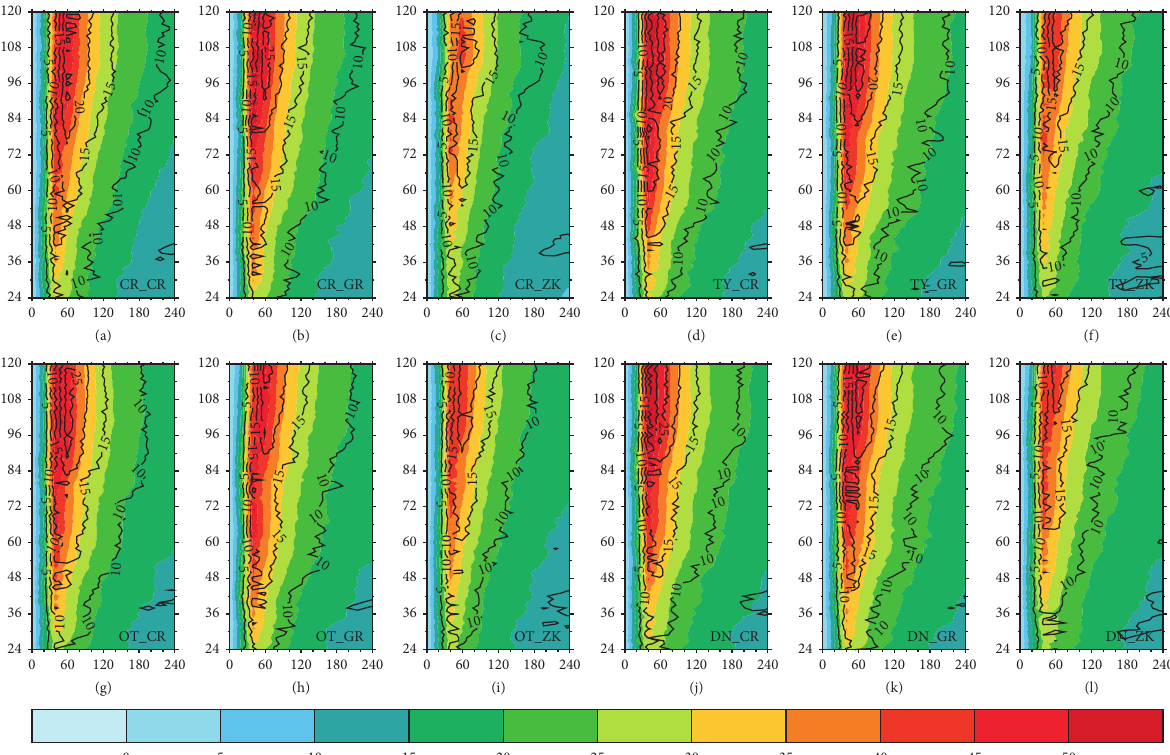
Figure 6: Hovm¨oller diagrams of azimuthally averaged tangential winds (colors, m/s) and radial winds (black lines, m/s) from 12 ex- periments. x -axis denotes the distance (km) from the center of the typhoon and y -axis denotes the forecast hours.